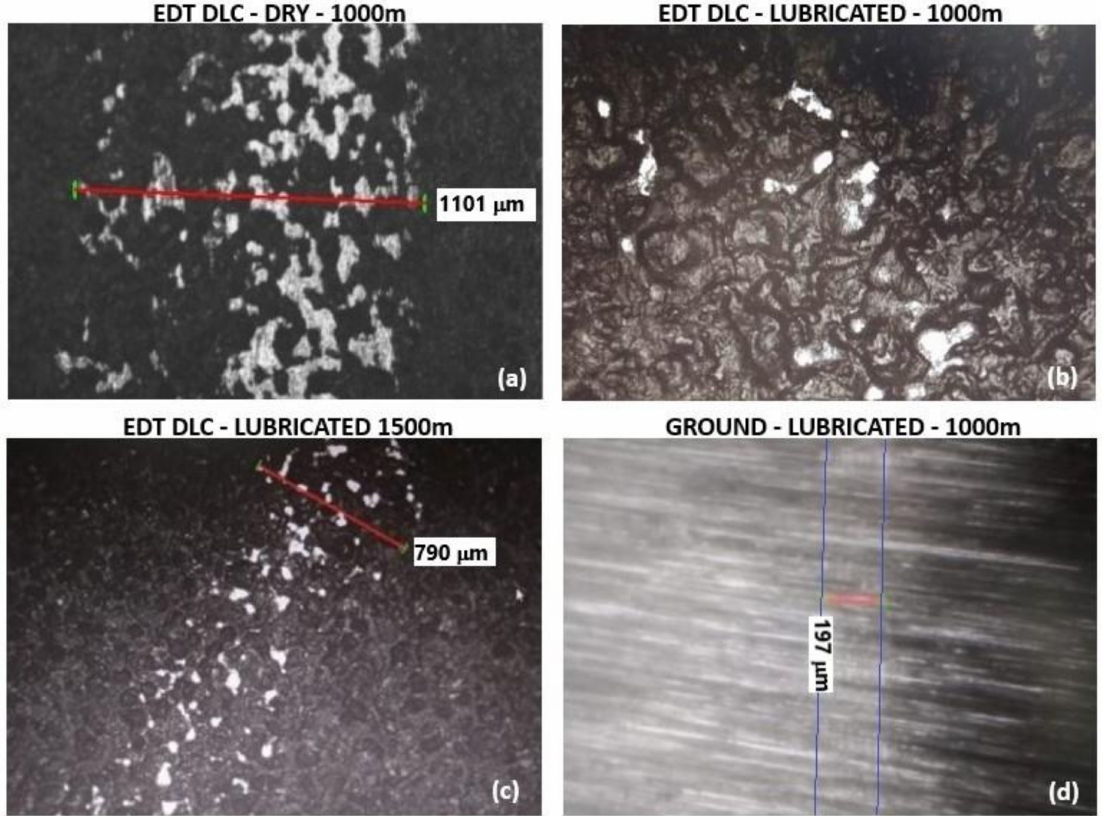
Figure 12. Examples of optical images of the worn tracks under dry and lubricated